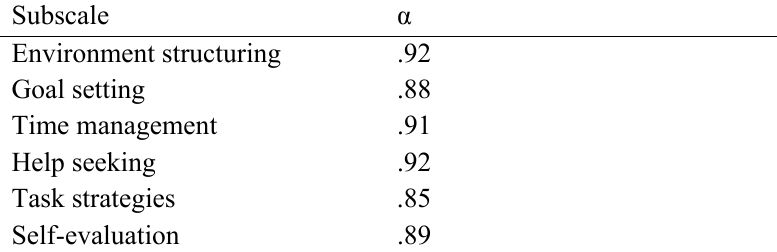
Study One Internal Consistencies for each Subscale Subscale α Environment structuring .92 Goal setting .88 Time management .91 Help seeking .92 Task strategies .85 Self-evaluation